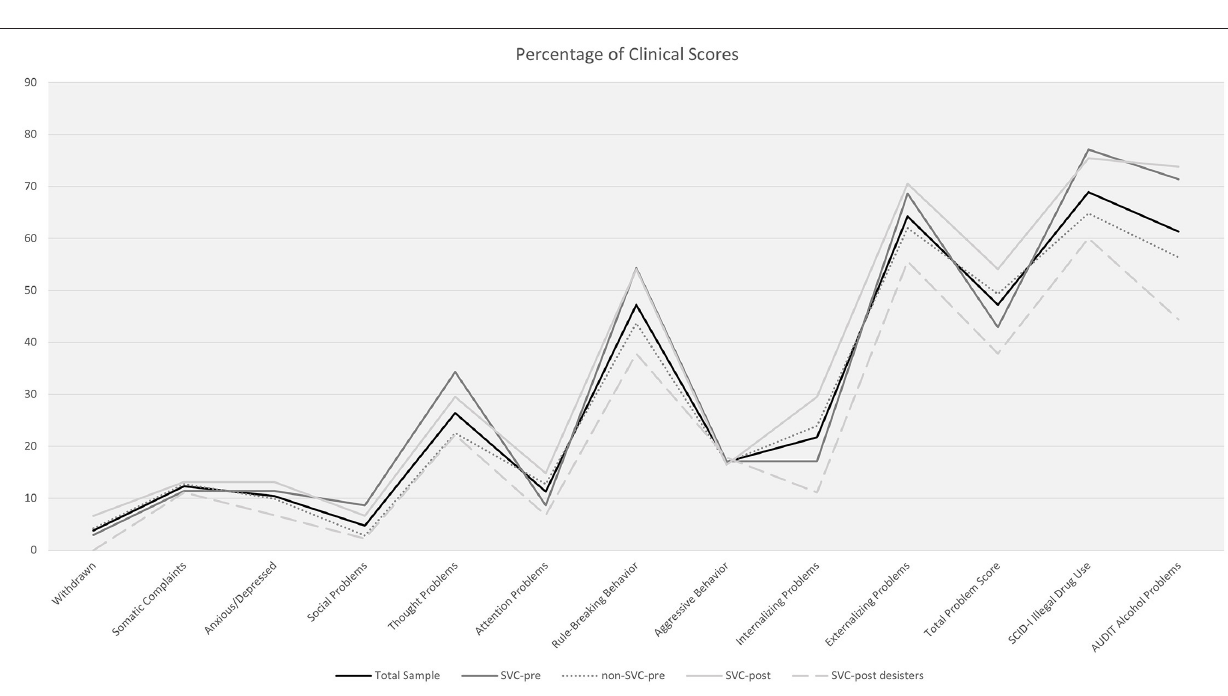
FIGURE 2 | Percentages of YSR/YASR, SCID-I and AUDIT clinical scores for the total sample ( N = 106) and for SVC offender